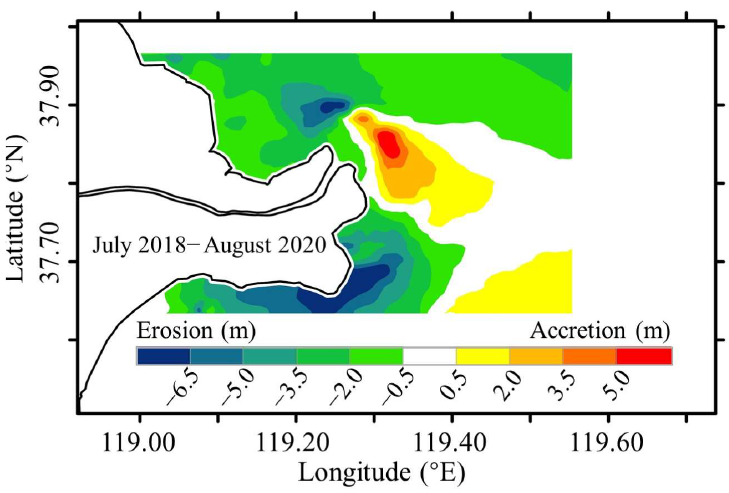
Figure 9. Erosion and accretion patterns in the subaqueous delta during the period of 2018–2020. Table 3. Quantification of erosion-accretion areas and volumes during extreme riverine floods.